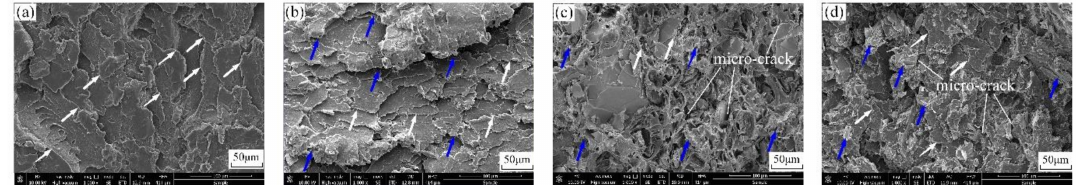
Figure 7. SEM images of fracture surfaces ( a ) PEEK, ( b ) PG07, ( c ) PM15, and ( d )